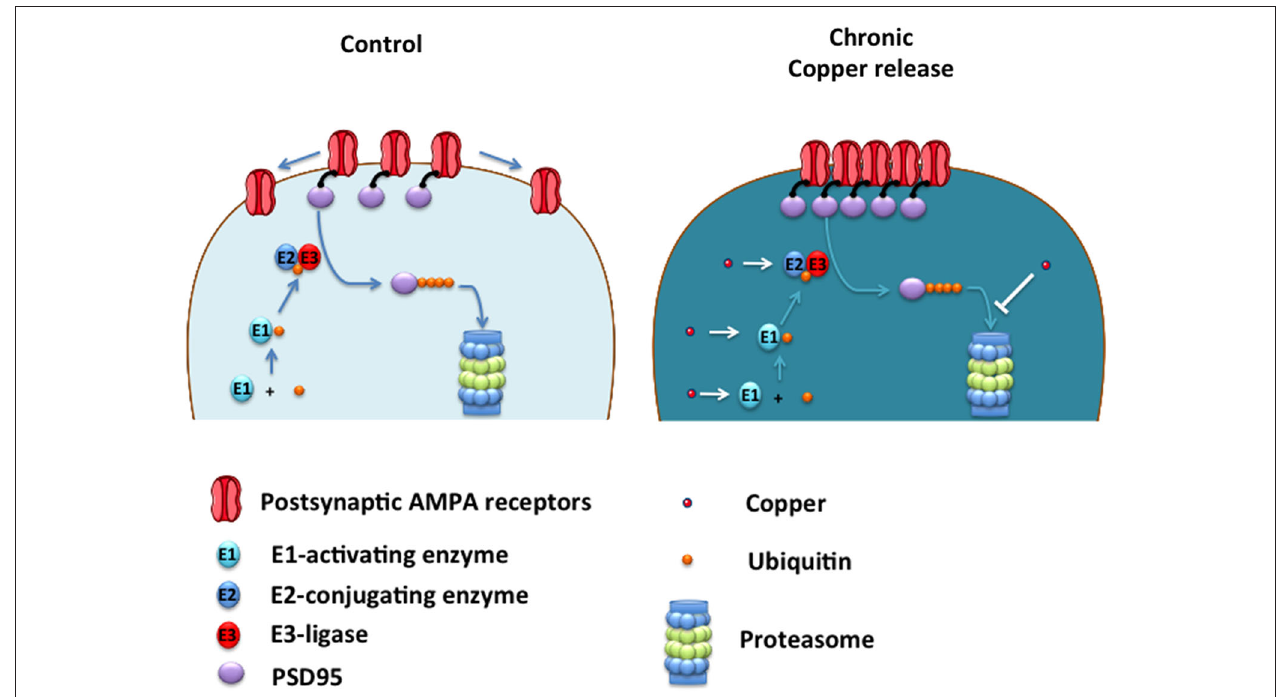
may promote the ubiquitination of PSD95 by acting as a cofactor of the E1-E2-E3 enzymes, promoting the ubiquitination of PSD95 and a subsequent saturation of the proteasome, slowing down PSD95 degradation leading to AMPA receptor clustering at the plasma membrane. Alternatively, copper can inhibit the proteasome directly impeding PSD95 degradation and promoting the formation of AMPA clusters at the postsynaptic membrane with a concomitant enhancement of AMPAergic